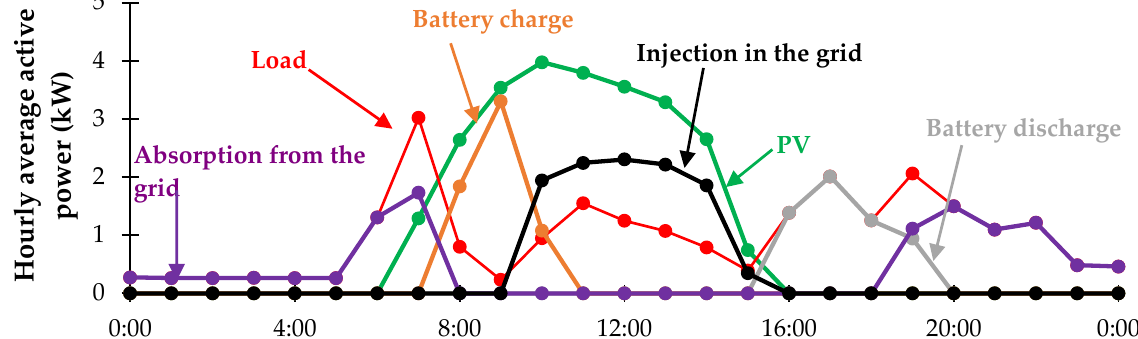
Figure 12. Example of hourly energy profiles of the analyzed residential user during an autumn day.